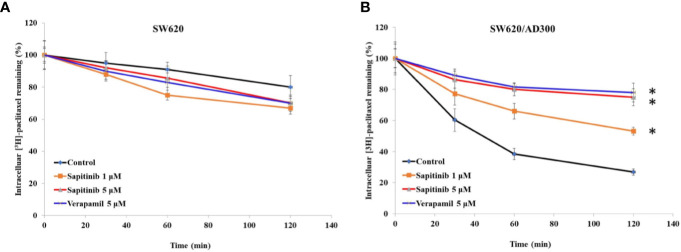
The effect of sapitinib on the in vitro intracellular accumulation of [3H]-paclitaxel in SW620 and SW620/Ad300 cancer cells. (A) The intracellular accumulation of [3H]-paclitaxel in SW620 cancer cells following incubation with sapitinib or verapamil. (B) The intracellular accumulation of [3H]-paclitaxel in SW620/Ad300 cancer cells following incubation with sapitinib and verapamil. The data represent the mean ± SD. *P < 0.05 compared to the control group.